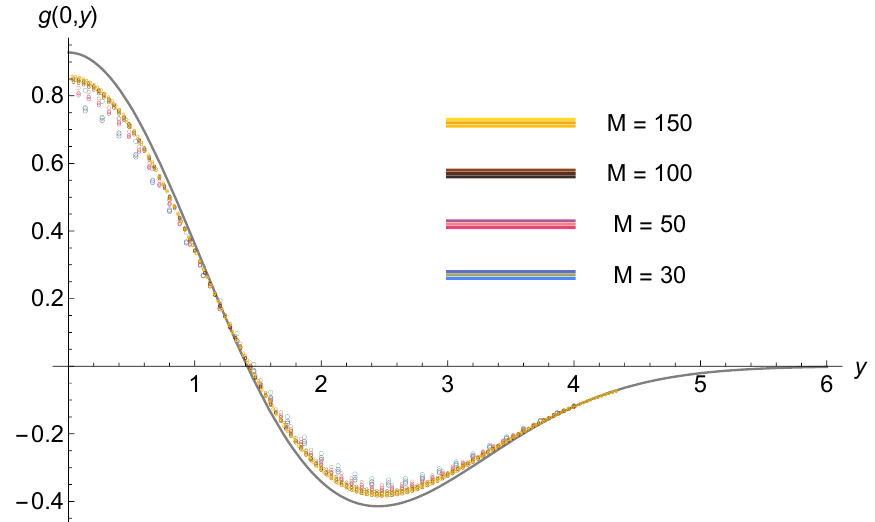
Figure 4: Same as figure 3 but with correlation functions calculated numerically for energy windows centered at E